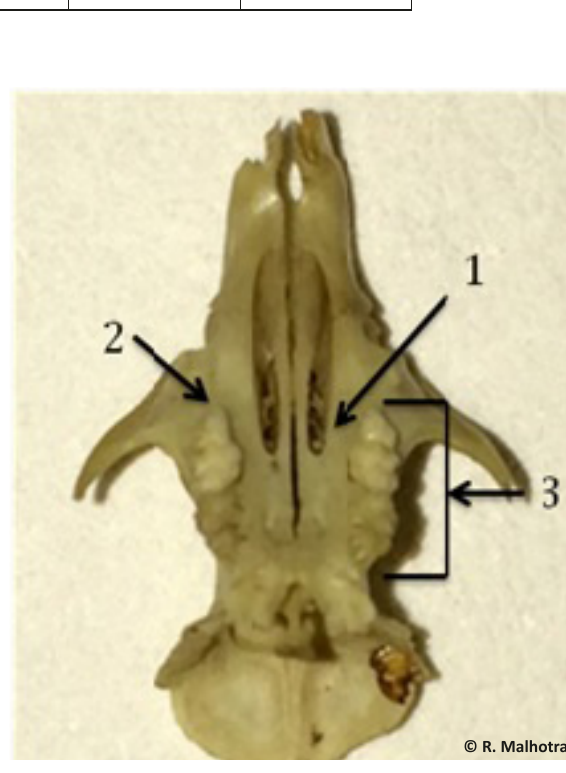
Figure 6. Ventral view of skull material of field mouse, Mus booduga found in pellets of Spotted Owlet. Arrow (1) anterior palatal foramina long, extending posteriorly between maxillary tooth rows. Arrow (2) anterior accessory cusp on first upper molar tooth. Arrow (3) upper molar tooth